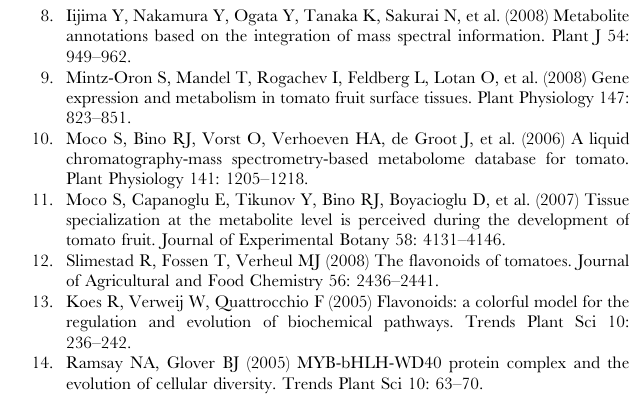
Figure S7 Cuticular wax composition in the y mutant and wt fruit peel at three tested stages of fruit development, as analyzed by GC-MS/FID. Wax constituents are sorted by compound classes according to carbon number in the chains (n= 5, error bars indicate standard errors). Figure S8 SlMYB12 assignment to tomato chromosome 1. (A) BstBI digestion of SlMYB12 genomic fragments amplified from the tomato set of interspecific introgression lines between cv. M82 and Lycopersicon pennellii [58]. (B) The Il1-1 pennellii chromosome segment, which does not overlap with other introgression lines resides between 17 CM to 41 CM. Figure S9 Multiple alignment of flavonoid-related MYB tran- scription factors and the SlMBY12 alleles. (A) Multiple alignment of the flavonoid related factors that were down-regulated in the y mutant (tomato THM27/MYB4, MYB4-like and MYB12 puta- tive protein products of TC174616 and other gene sequences that were reconstructed in this study), their closest paralogue (putative protein product of SlMYB12-like that was reconstructed in this study) and protein products of their Arabidopsis orthologues (MYB11 and MYB12, NP_191820 and NP_182268, respectively) as well as the predicted protein product of the SlMYB12 allele, y-1 . Amino acid (aa) substitutions and the aa deletion in the y-1 allele are indicated in pink. (B) Nucleic acids alignment of the two SlMYB12 alleles. Exonic and intronic sequence differences are highlighted in grey. Red asterisks and underlines indicate premature polyadenylation (pad) sites of the y-1 transcripts. Out of 20 sequenced RACE products 4, 4, 3, 4, 3 were pad1a, pad2a, pad3a, pad4a, pad5a, pad6a versions and the short wt version, respectively. Figure S10 Total Ion Chromatograms of y , cv. AC, 35S:amiR- SlMYB12 and cv. MT peel samples at the red stage of fruit development, acquired in negative mode by the UPLC-QTOF- MS instrument. Putative identifications of the differential com- pounds are: 1- quercetin-dihexose-deoxyhexose, 2- quercetin- hexose-deoxyhexose-pentose, 3- quercetin rutinoside (rutin), 4- phloretin-di-C-hexose, 5- kaempferol-glucose-rhamnose, 6- nar- ingenin chalcone, 7- dicaffeoylquinic acid III, 8- tricaffeoylquinic acid. Red and blue numbers indicate metabolites that showed elevated or reduced levels in the mutant/transgene samples